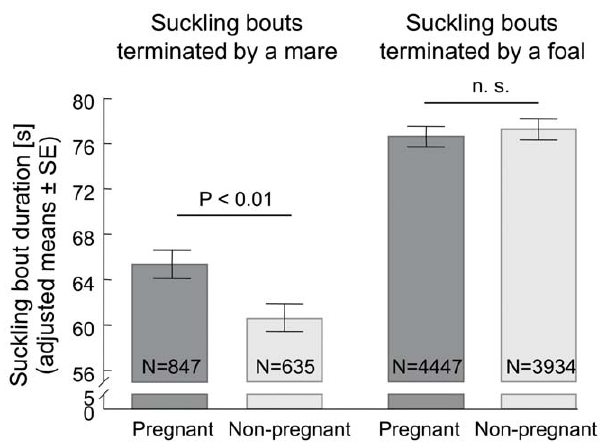
Figure 1. Suckling bout duration [s] according to the repro- ductive status of the mother when suckling bouts terminated the mother (left) or the foal (right). (Differences between categories including different terminator of a suckling bout were all P , 0.0001.)